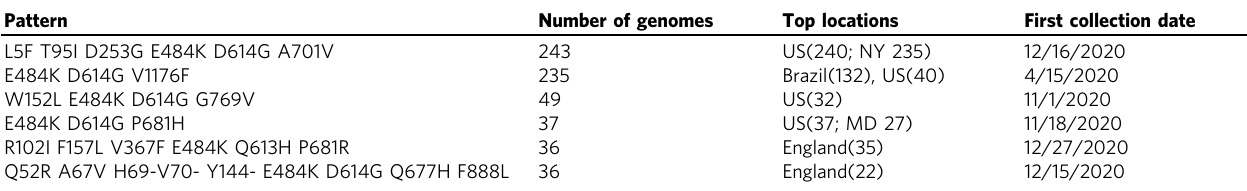
Table 1 Mutation patterns of viruses with mutations at select Spike positions, excluding viruses related to variants